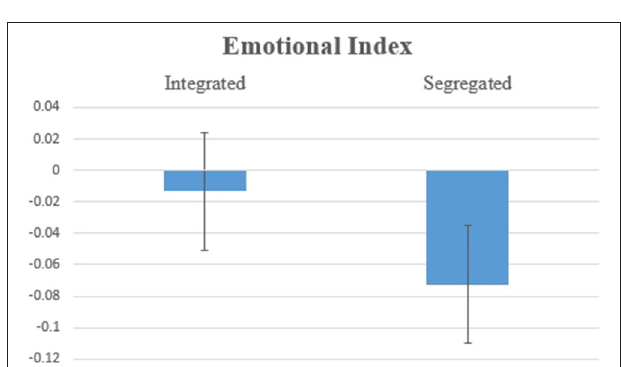
FIGURE 6 | Average values for Emotion Index for BP/SN, two pieces of information integrated vs. segregated. The difference was statistically significant at F (1,13) = 8.574, p = 0.012.